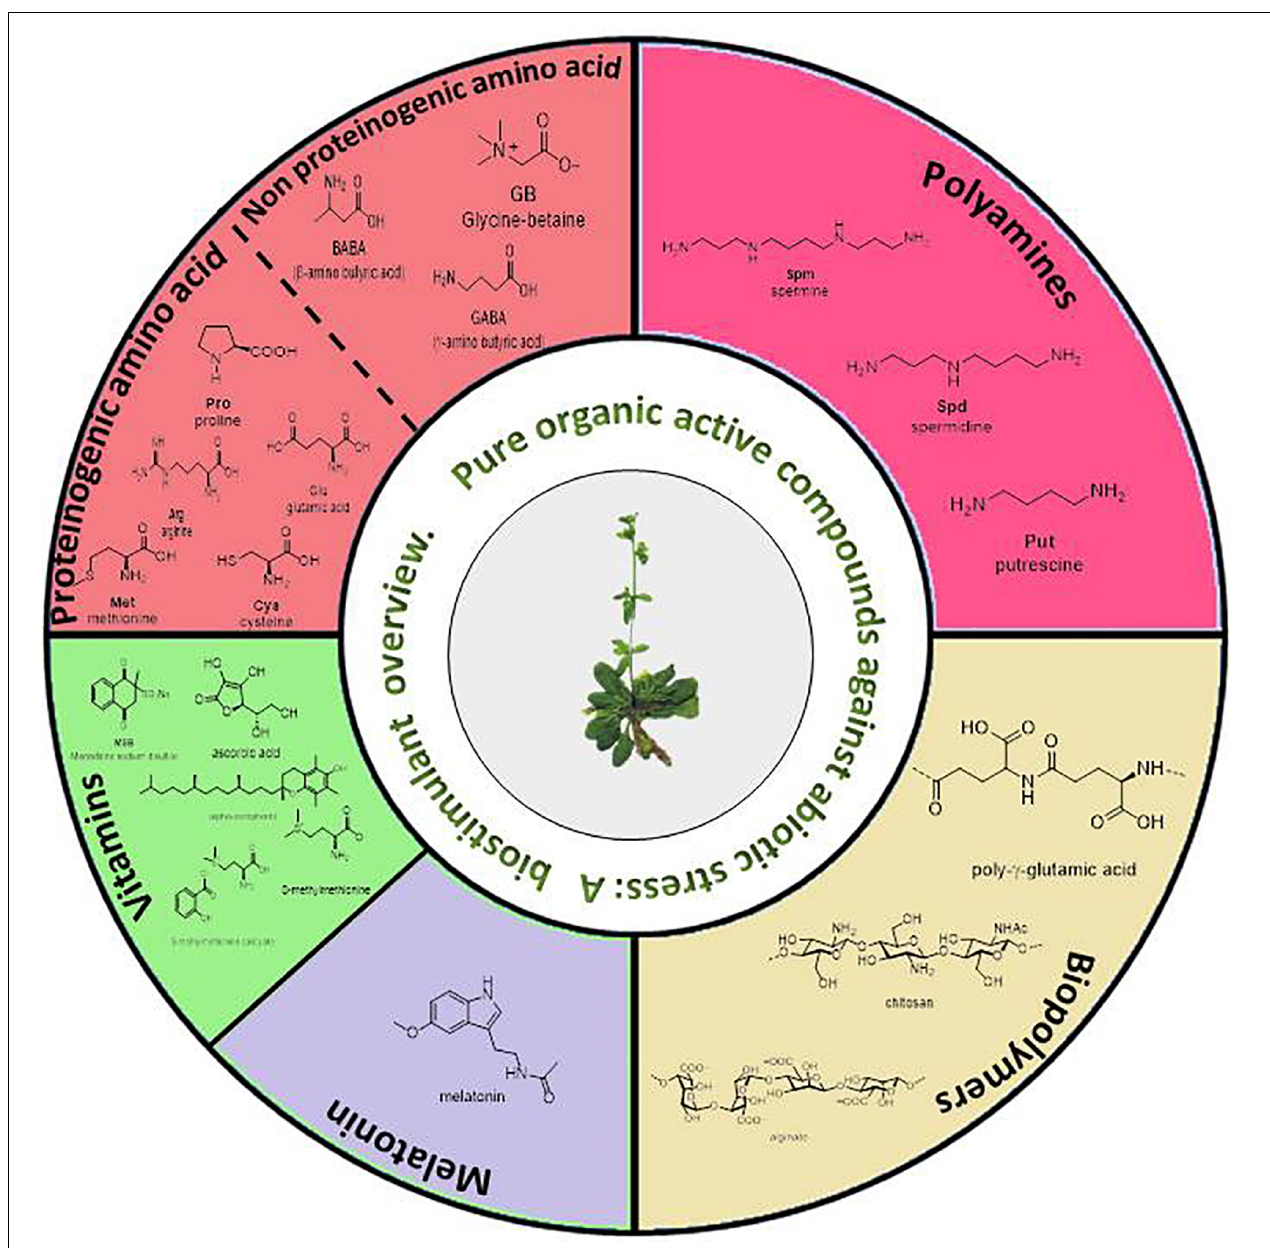
FIGURE 3 | Summary of pure organic active compounds addressed in this